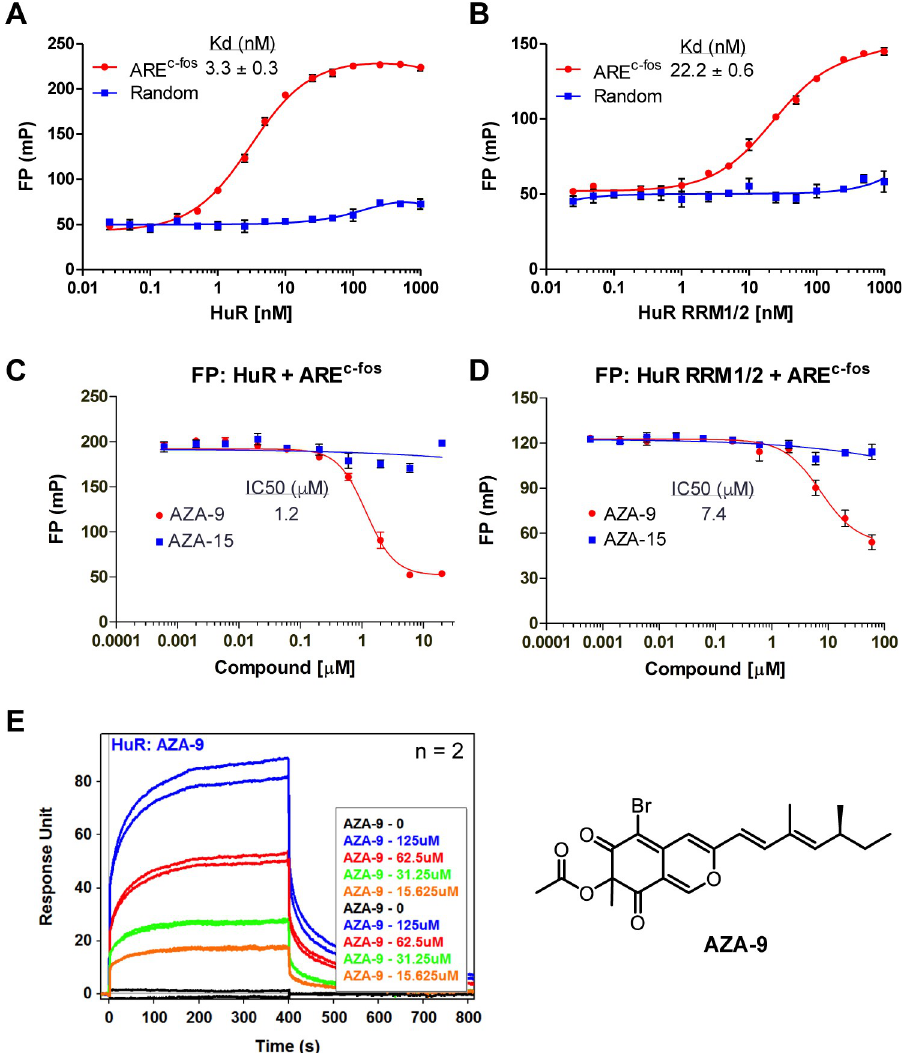
Fig 1. AZA-9 inhibits HuR-ARE RNA interaction and binds directly to HuR. Titration of 2 nM ARE c-fos and control RNA (a 16-nt fluorescein-labeled RNA oligo with random sequence)with (A) HuR and (B) HuR RRM1/ 2 (n = 3). (C) Dose-response curve of AZA-9 disruptingHuR-ARE c-fos bindingin FP assay using 10 nM HuR and 2 nM fluorescein-labeledARE c-fos (n = 3). (D) Dose-response curve of AZA-9 disrupting HuR RRM1/ 2-ARE c-fos bindingin FP assay using 50 nM HuR RRM1/2 and 2 nM fluorescein-labeledARE c-fos (n = 3). (E) SPR sensorgrams of AZA-9 injectedat increasingconcentrations of 0–125 μ M into a flow cell containing immobilizedHuR (n = 2). Structure of AZA-9 is shown on the right. The followingwere the negative controls used–random RNA in (A) and (B); and AZA-15 in (C) and (D) .